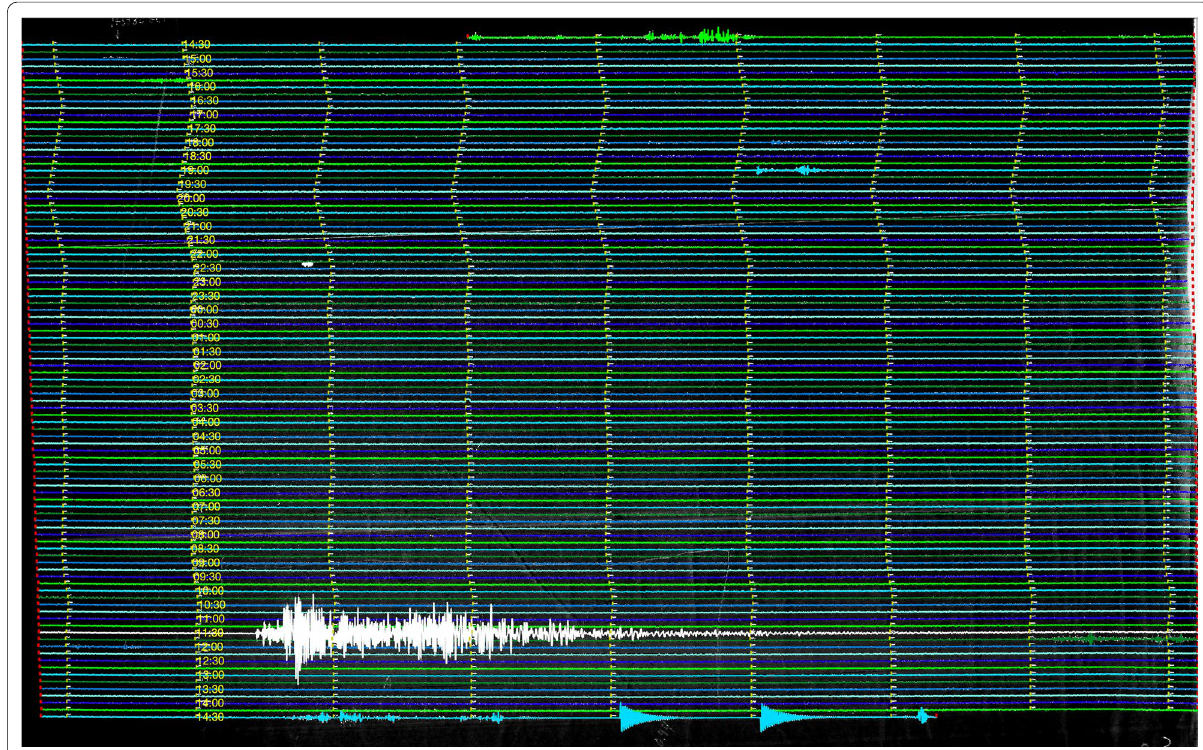
Fig. 5 Digitization Example 2: 1945 Trinity Nuclear Test. Digitization of the right side from the 35 mm microfilm copy of the short-period vertical record from Tucson, Arizona, covering the time between 14:17 on July 15 to 14:35 on July 16, 1945. The features are the same as in Fig. 4 except that only the image part of the DigitSeis screen is shown and the digitized traces are displayed with green and blue colors. There is a trace that is shown with white color to emphasize the blast signals associated with the Trinity nuclear detonation at 11:30 UTC. The time stamps are provided at 30-minute intervals. Short segments that appear regularly above the digital traces are the time marks in the background image. See Fig. 3 for the digitization result using the full photographic paper